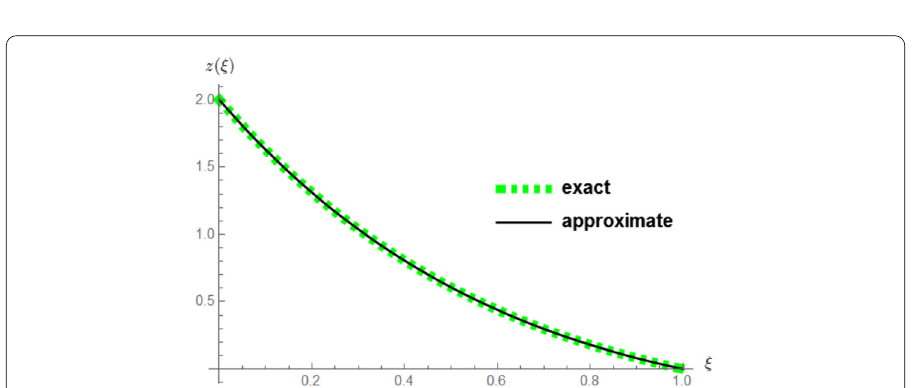
Figure 4 Exact and MRKHS solution curves of Example 5.4